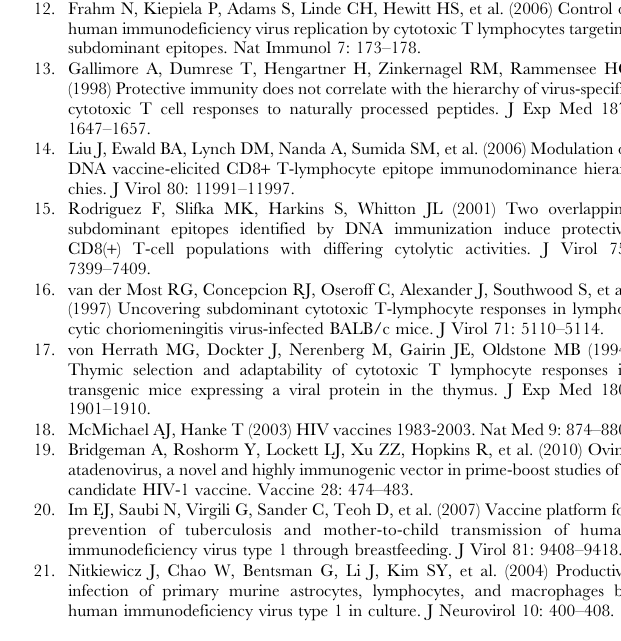
Figure S2 T2 assays for peptide binding affinity for MHC class I. TAPdeficient T2 cell lines stably transformed with H-2Dd, H- 2Kd or H-2Ld complexes were kindly provided by Dr Hansen, Washington University. Peptide-loaded MHC complexes were detected by fluorochrome-conjugated mAb (DB Biosciences) and the cells were analyzed using flow cytometer. A) Index and mutated peptides P and G1 or B) peptide NNP as indicated above the histograms as peptide-MHC were tested at decreasing concentrations ranging from 100 m M to 0.01 m M (pink 100 m M, turquoise 10 m M, orange 1 m M, green 0.1 m M, blue 0.01 m M and grey filled no peptide) for binding to MHC class I complexes. Figure S3 Spatial and temporal separation of dominant and subdominant epitopes during vaccination (Additional data for Figure 4). Groups of 4 BALB/c mice were given 2x a total of 100 m g DNA at 4-wk intervals as indicated in Figure 4B with the HIVA or HIVAdH vaccines being given either mixed or separately into the muscles of the left and right hind legs. After a 23-wk rest, the mice were briefly re-stimulated with recombinant vaccinia virus WR.HIVA delivered i.p. and their H, P and G1- specific responses were analyzed using a multicolour flow cytometry 4 d later. Representative examples are shown from one mouse of each